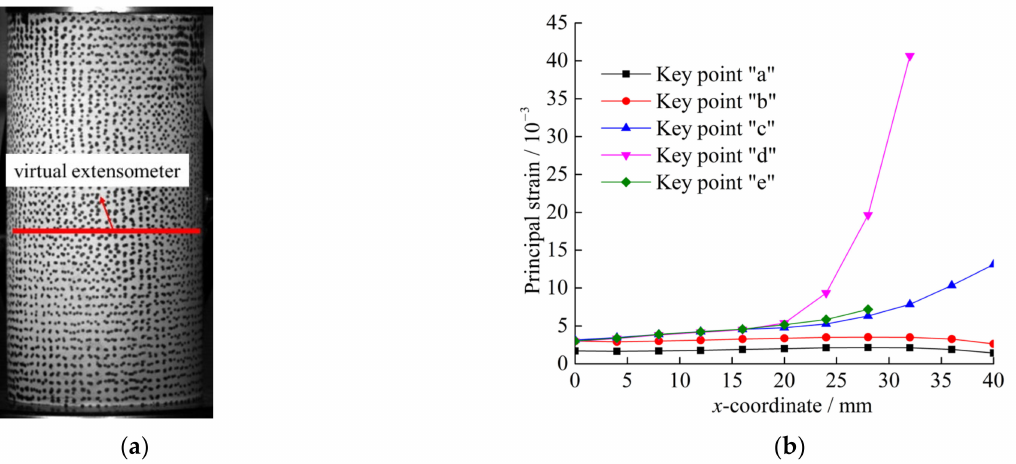
Figure 8. Virtual extensometer layout and principal strain values at different stages: ( a ) Position of virtual extensometer; ( b ) Principal strain at different loading